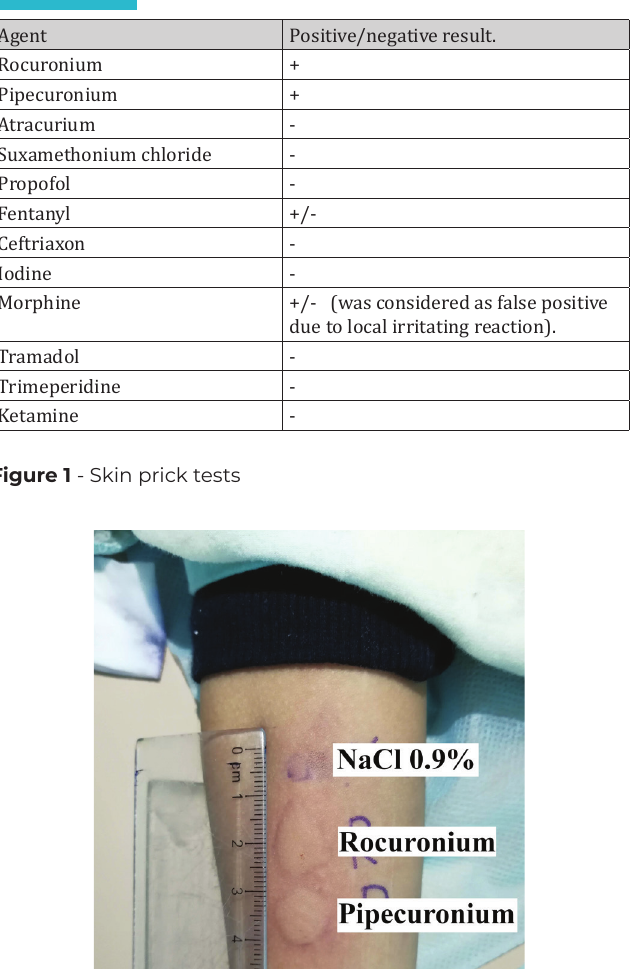
Table 1 Results of skin prick